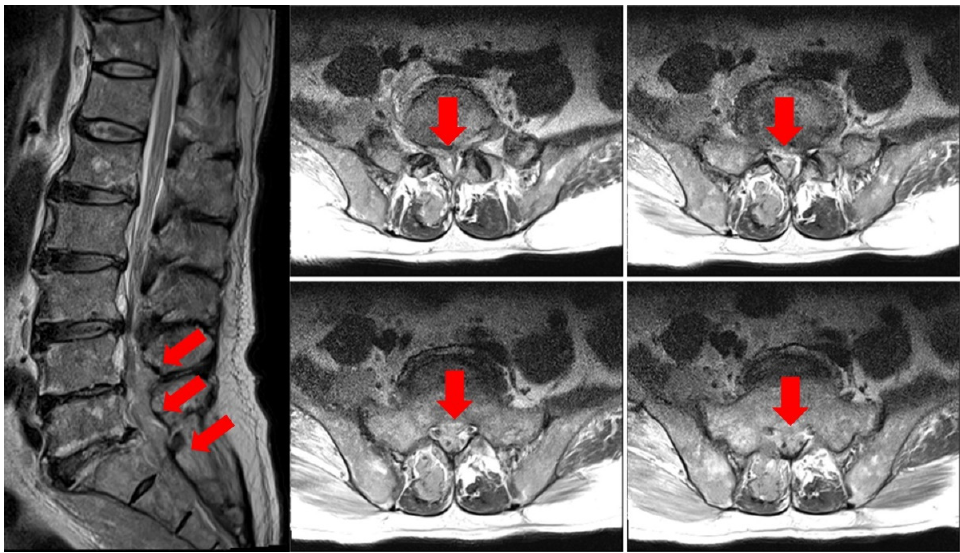
Figure 1. Lumbar spine MRI T2 weighted image. Epidural metastasis at L4/5, L5/S1, and the sacrum is noted (arrows).